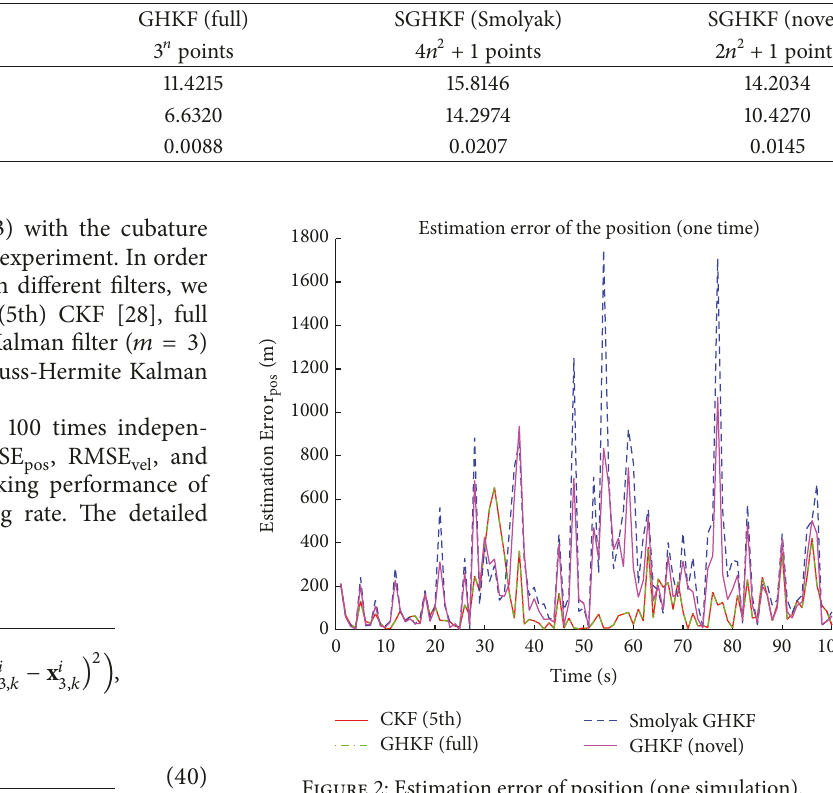
times. 𝑁 sim represents the state number of each